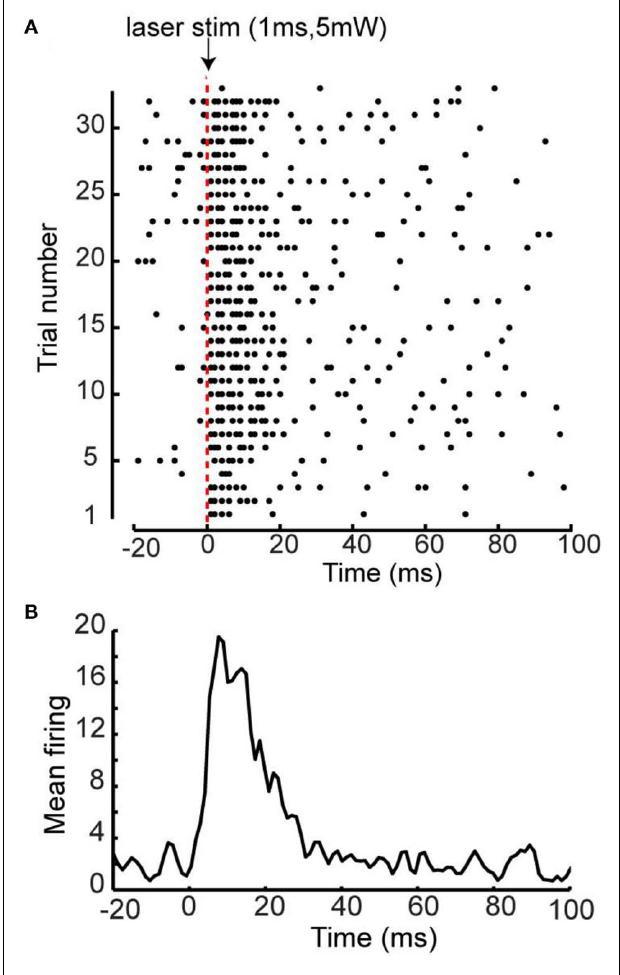
FIGUREA1 | Optrode recordings from FLS1 ofThy1-ChR2 transgenic mice following photostimulation. (A) Raster plot of neuronal